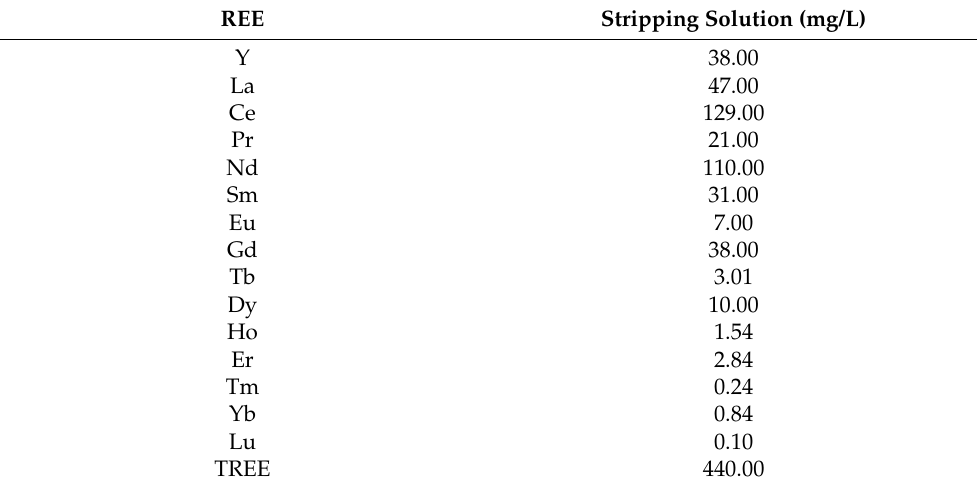
Figure 1. Schematic representation of processing circuits for recovery of REEs from acid mine drainage precipitate (AMDp). Table 1. REE and major metal concentrations for the stripping solution utilized in testing.